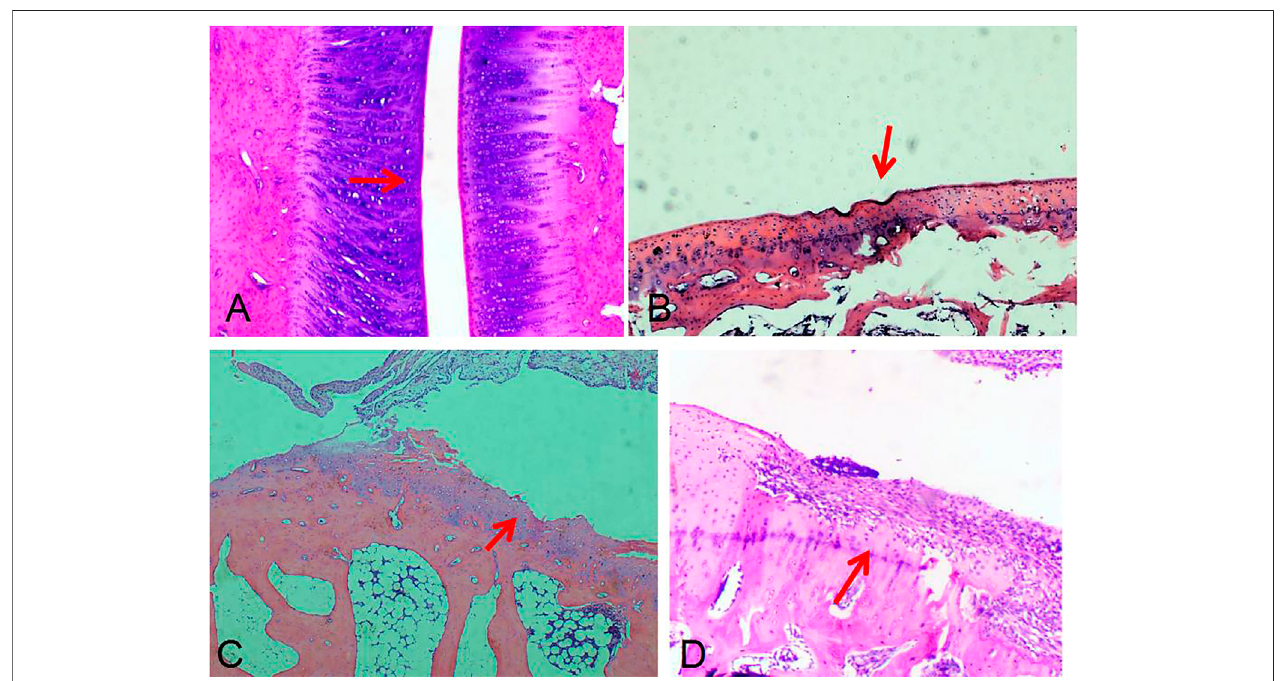
FIGURE 9| Pathological results of bone destruction. Score 0: the surface of bone was smooth and no bone damage was found (TP-SLN group, (A) ). Score 1: the bone surface is not smooth (TP group, (B) ). Score 2: slight bone defect on the bone surface (DMSO group, (C) ). Score 3: extensive bone destruction on bone surface (control group, (D) ). (red arrow, HE,